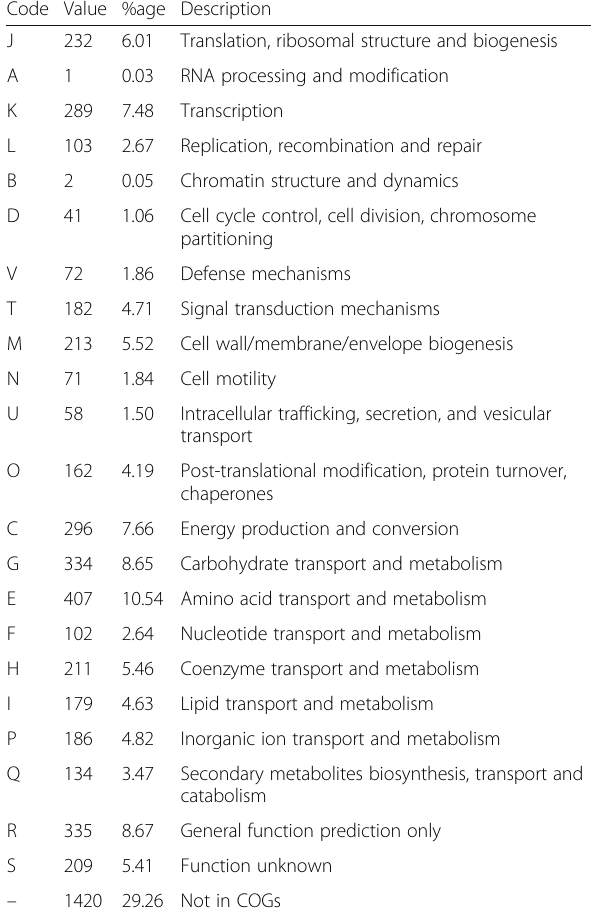
Table 4 Number of genes associated with general COG functional